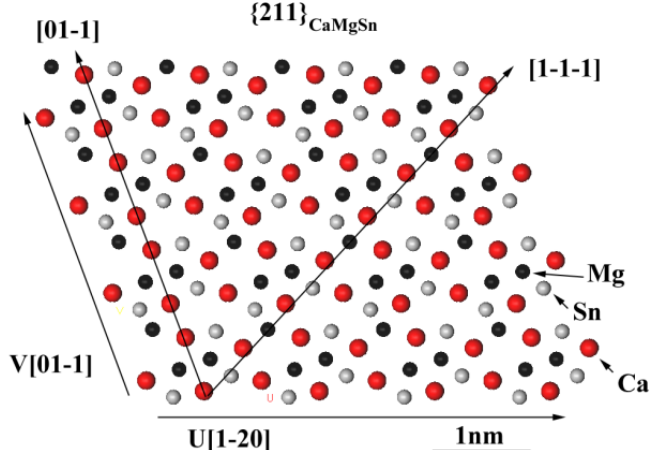
Figure 6. Atomic configurations of CaMgSn on its close-packed plane {211} CaMgSn .